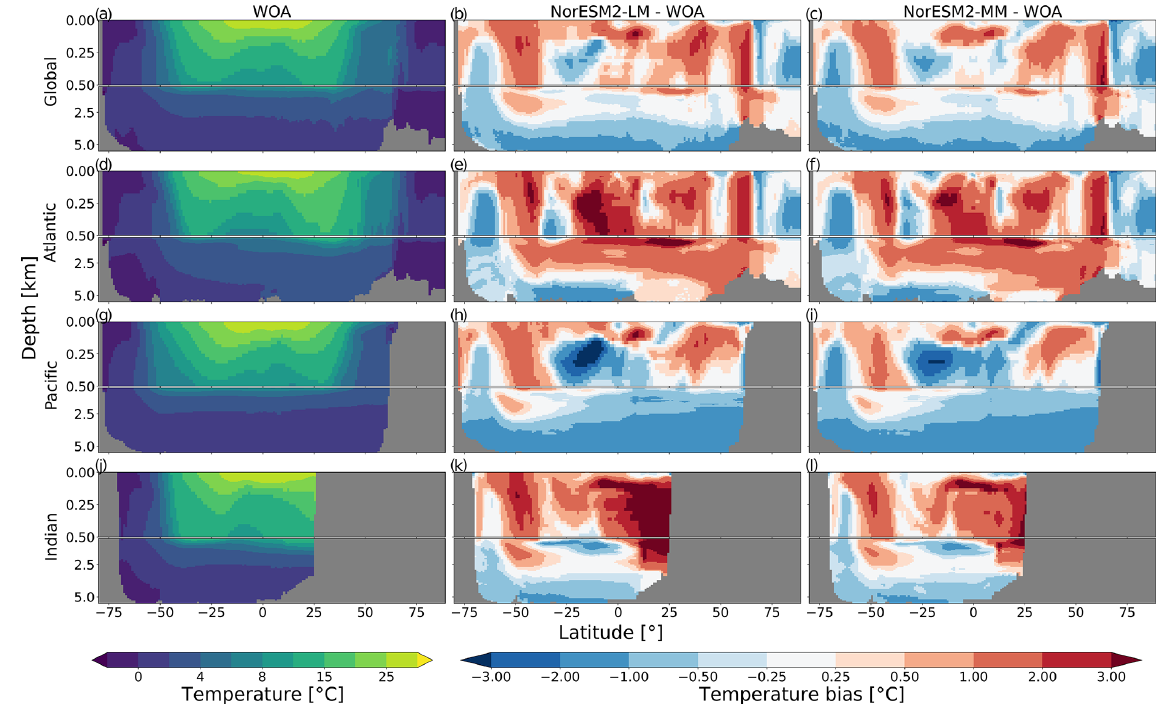
Figure 10. Zonal-mean bias in potential temperature for NorESM2-LM and NorESM2-MM. The bias is taken relative to World Ocean Atlas climatology (Locarnini et al., 2018; Zweng et al., 2018) using the years 1981–2010 in the main ocean basins. Note the change in the vertical scale between the upper 500m and the lower 4500m. For the model biases, we show the ensemble-mean bias using three historical members.